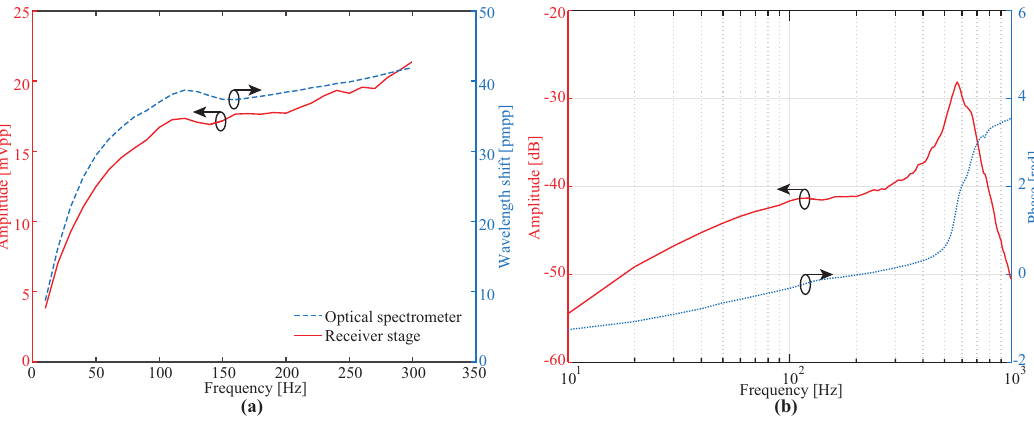
Figure 5. ( a ) Peak to peak relation between wavelength shift and electrical amplitude as a function of the modulation frequency and ( b ) transfer function of the proposed